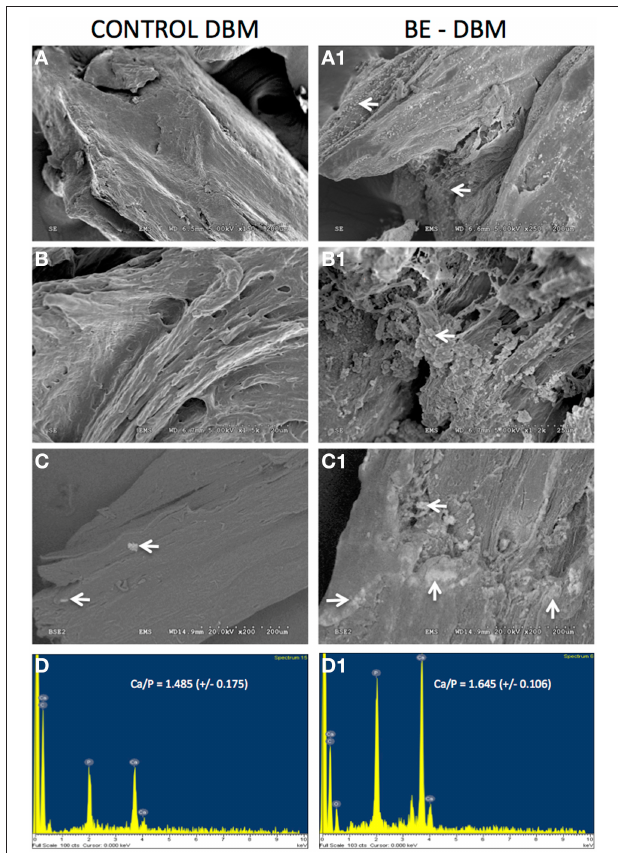
FIGURE 5 | In vitro calcium phosphate nucleation. Panels (A–C) are representative electron micrographs of DBM samples subjected to in vitro calcium phosphate nucleation. Panels (A1–C1) are electron micrographs of BE-DBM samples subjected to in vitro nucleation. Note the increased deposition on the BE-DBM samples. Panels (C,C1) were acquired using samples that were not coated with pt/pd. White arrows in (C,C1) indicate areas of calcium phosphate deposition. Panels (D,D1) are representative EDX spectrums of DBM and BE-DBM samples respectively showing the presence of calcium and